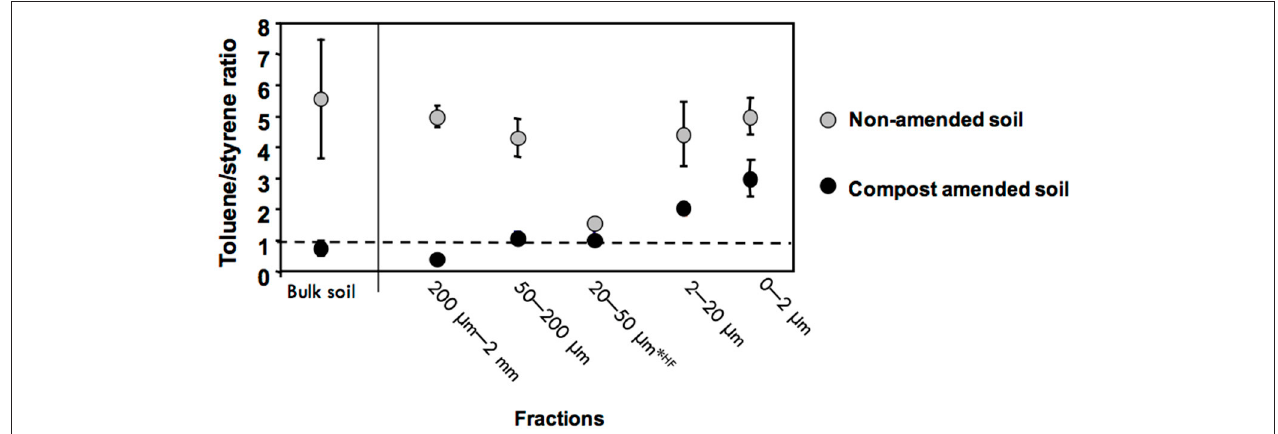
FIGURE 6 | Toluene-to-Styrene ratio in the control and the amended soil and in their fractions (means and error bars from three replicate pyrolysis analysis). Fractions 20–50 µ m were analyzed after HF